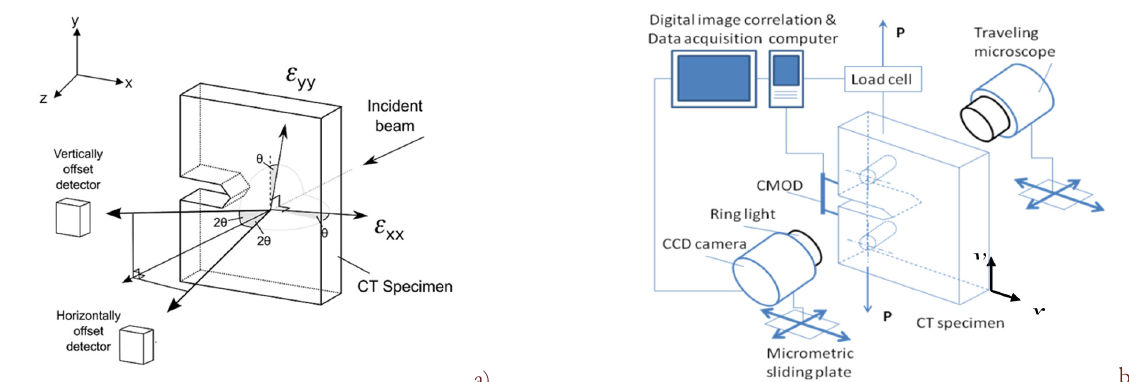
Figure 1: Schematics showing a) the diffraction geometry with two detectors so as to measure two in-plane directions of strain; note the coordinate system for  xx and  yy . For very low  these strains can be taken as representative of those in the loading (y) and crack growth (x) directions, b) the DIC arrangement [9]. In actual fact the camera viewed the sample at a slight angle to allow the X-ray beam unimpeded access to the